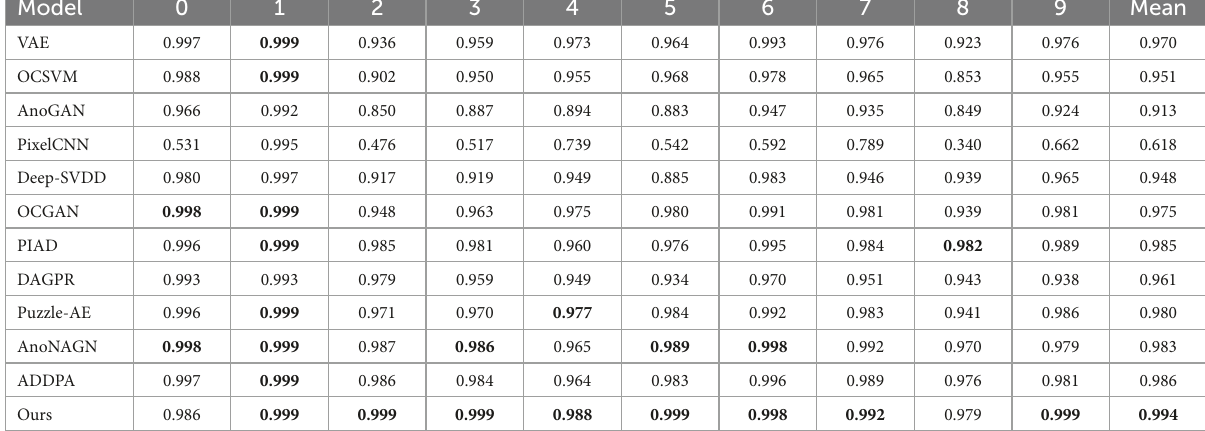
TABLE 2 Anomaly detection results for MNIST dataset.